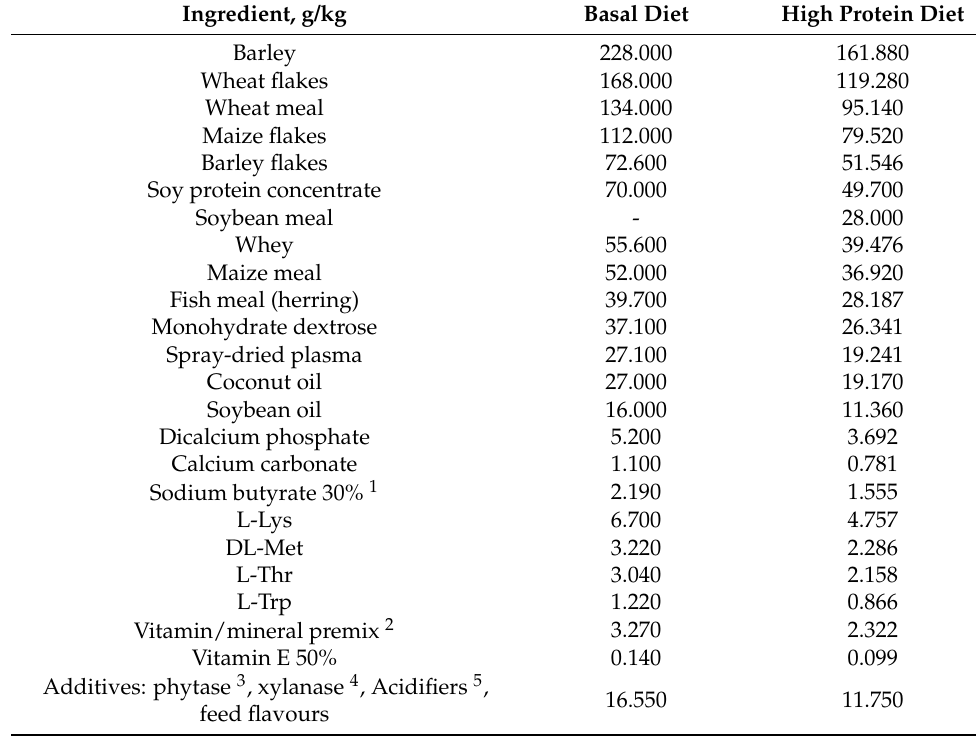
Table 1. Composition of the experimental